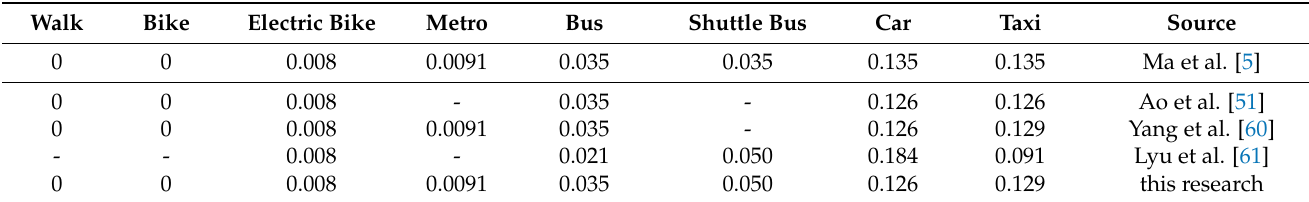
Table 2. CO 2 emission factors for different modes of transportation (kg CO 2 /person · km).